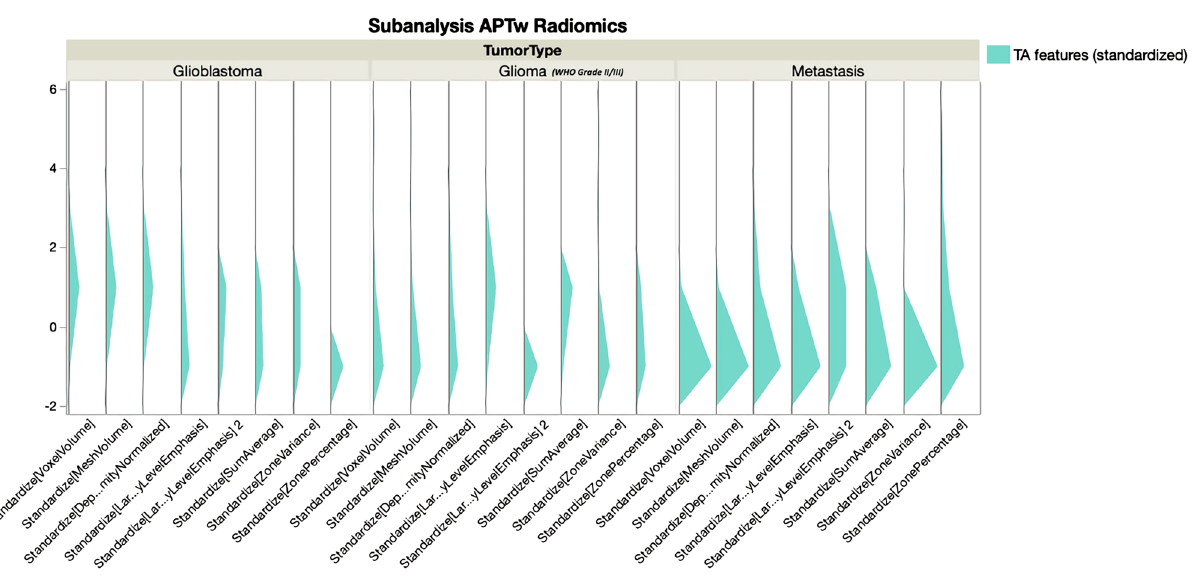
Figure 4. Relative visualization of the eight standardized texture analysis features for glioblastomas, other gliomas and metastases. Overall lower values are observed for metastases compared to glioblastomas and other gliomas,